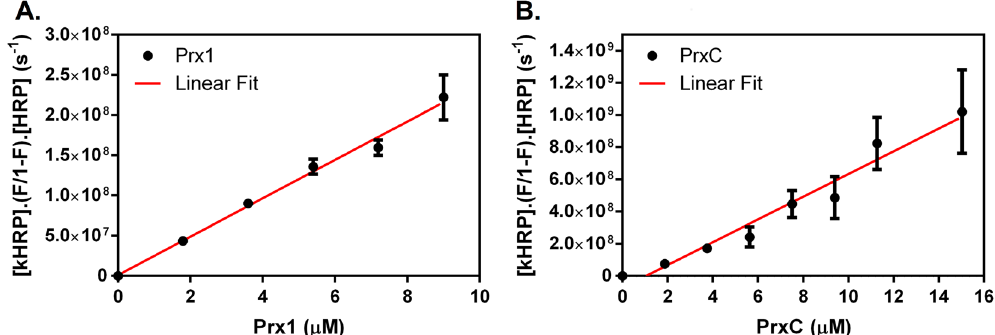
Figure 2. Oxidation rates of A . fumigatus Prx1 and PrxC. The second-order rate constants for the reactions of Prx1 ( A ) and PrxC ( B ) were determined using growing concentrations of Prx (2–16 μ M) with H 2 O 2 (4 μ M) by the competition with HRP (horseradish peroxidase) (8 μ M). The rates were determined as k Prx1 = 2.28 × 10 7 M − 1 s − 1 and k PrxC = 7.07 × 10 7 M − 1 s − 1 . The left y-axis is relative to the enzyme activity and the x-axis is relative to the enzyme concentration added to the reaction. The results shown are mean ± SD obtained from three independent